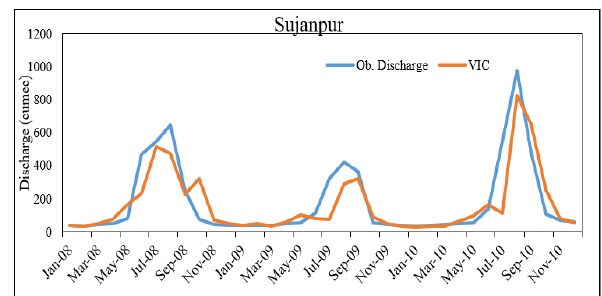
Figure 8 Plot of simulated and observed discharge at Sujanpur during calibration period.